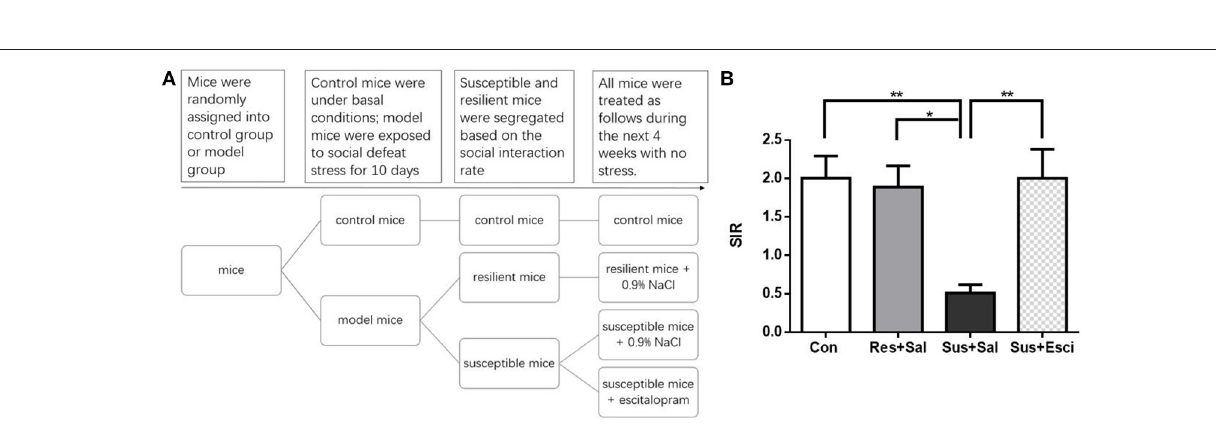
Frontiers in Neuroscience |